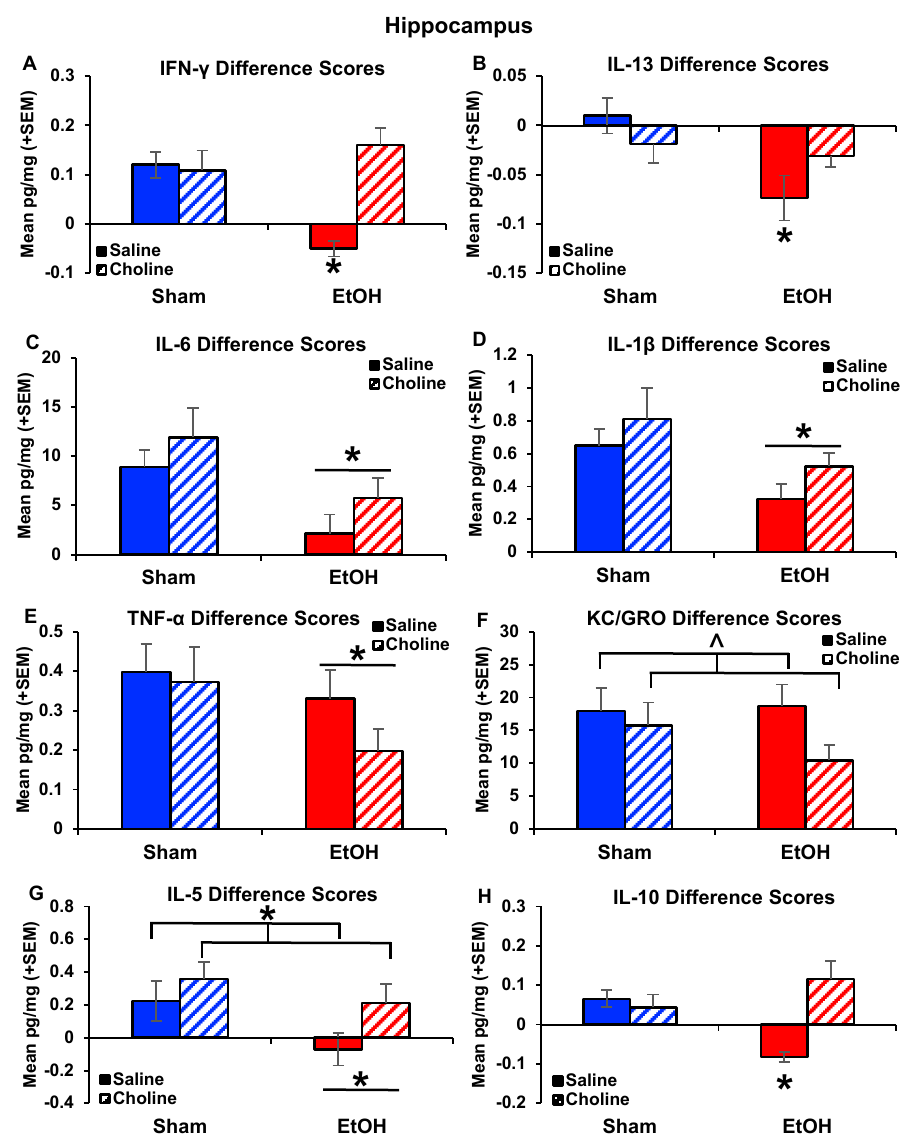
Figure 4. LPS-induced changes in hippocampal cytokines. Difference scores of cytokines after an immune challenge of LPS. There was an effect of ethanol exposure or choline supplementation on the following change in levels after LPS exposure for the following cytokines: ( A ) IFN- ɣ (EtOH + Choline > EtOH + Saline, * p < 0.05), ( B ) IL-13 (EtOH + Choline > EtOH + Saline, * p < 0.05), ( C ) IL-6 (EtOH < Sham, * p < 0.05), ( D ) IL-1 β (EtOH < Sham, * p < 0.05), ( E ) TNF- α (EtOH < Sham, * p < 0.05), ( F ) KC/GRO (Choline < Saline, ^ p < 0.10), ( G ) IL-5 (Choline > Saline, * p < 0.05 and EtOH < Sham * p < 0.05), and ( H ) IL-10 (EtOH + Choline > EtOH + Saline, * p < 0.05). n = 21–22 per group.